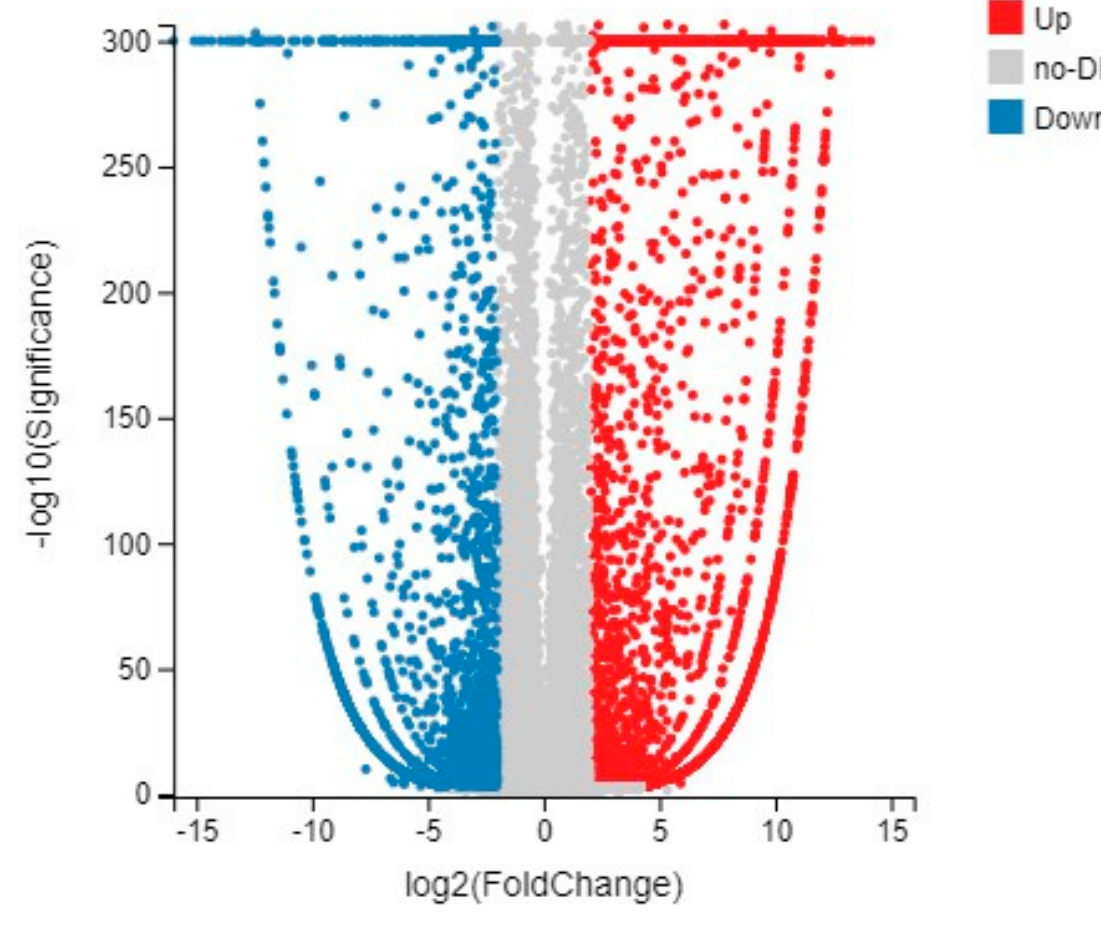
Figure 2. Volcanic map of differentially expressed genes between CK1 and CK2 . Note: X axis: difference multiple values, Y axis: significance value.